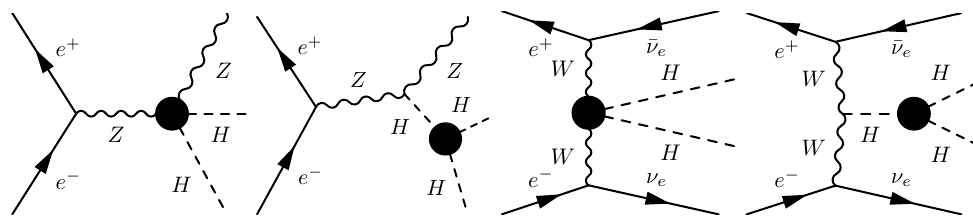
Figure 3 . Representative Feynman diagrams for double Higgs production. The black blobs corre- spond to the one-loop HHV V and HHH form